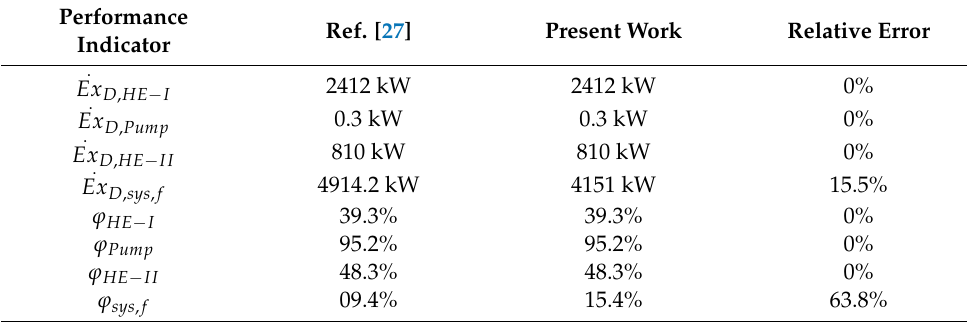
Table 4. Results of the validation of the develop model for case